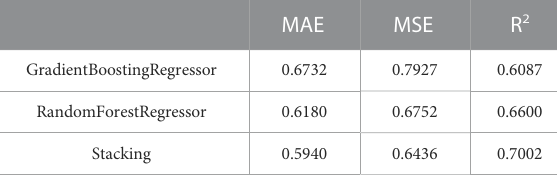
TABLE 5 Evaluation metric values for each